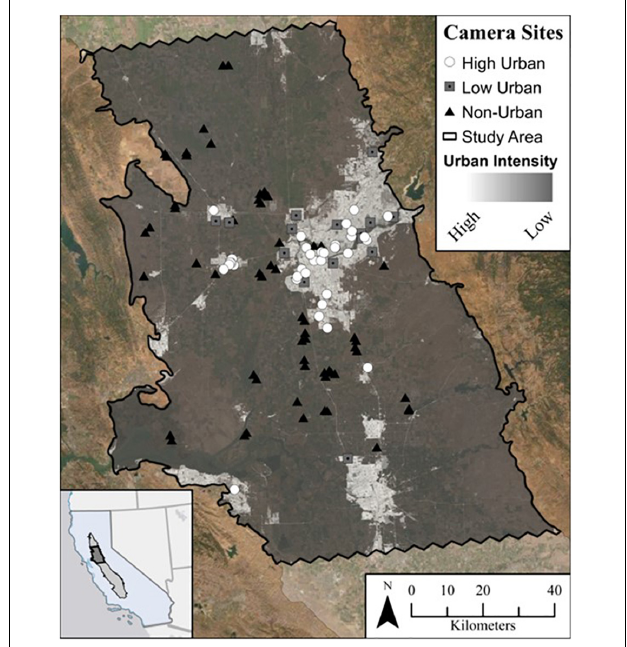
FIGURE 1 | Camera sites ( n = 110) across urban intensity in the Sacramento Metropolitan Area within California’s Central Valley. Urban intensity is based on a combination of imperviousness and building density within a 500 m kernel density search radius at 60 m 2 resolution. Cameras are labeled here as either high intensity urban (white circles; n = 34), low intensity urban (gray squares; n = 16), or non-urban (black triangles; n = 60) based on k-means